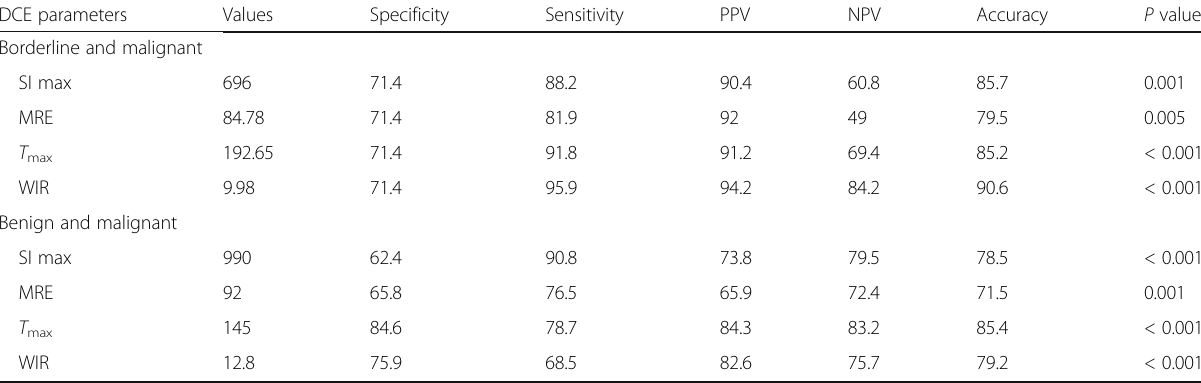
Table 7 The cutoff values of the DCE parameters for the benign& malignant and borderline and malignant adnexal lesions DCE parameters